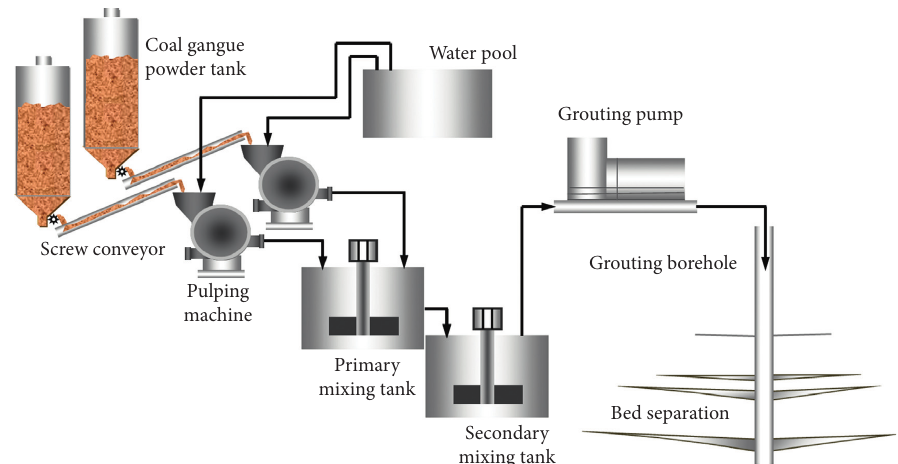
Figure 10: Schematic diagram of the grouting system.